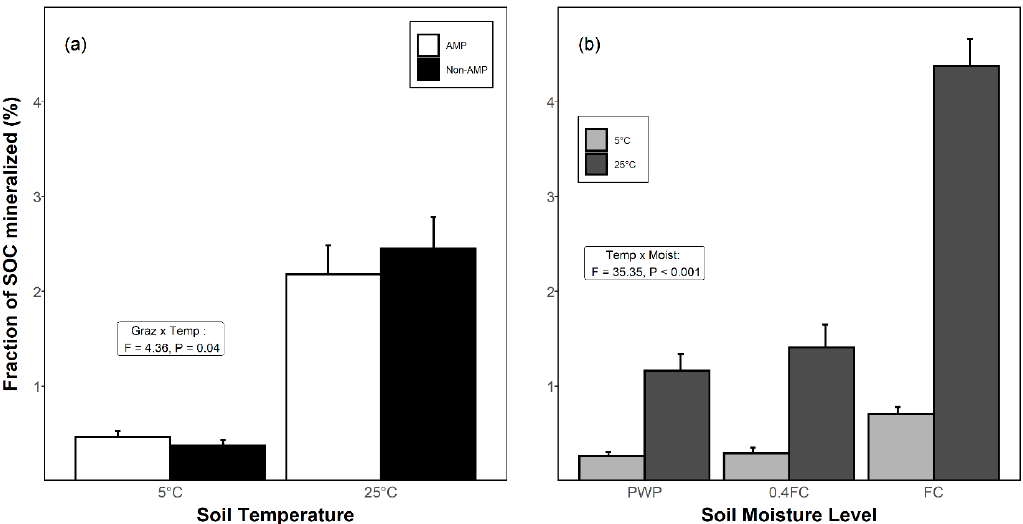
Figure 2. The proportion of SOC mineralized as CO 2 -C (mean ± SE) in soils from ( a ) adaptive multi-paddock (AMP) and conventional (non-AMP) grazing systems during a 102-day soil incubation under either ( a ) 5 °C or 25°C, or ( b ) at different moisture levels and subject to either 5 °C or 25 °C. Moisture levels were permanent wilting point (PWP), 40% of field capacity (0.4FC), and field capacity (FC). Statistics in inset boxes show the interaction between ( a ) grazing × temperature and ( b ) temperature × moisture ( p < 0.05).